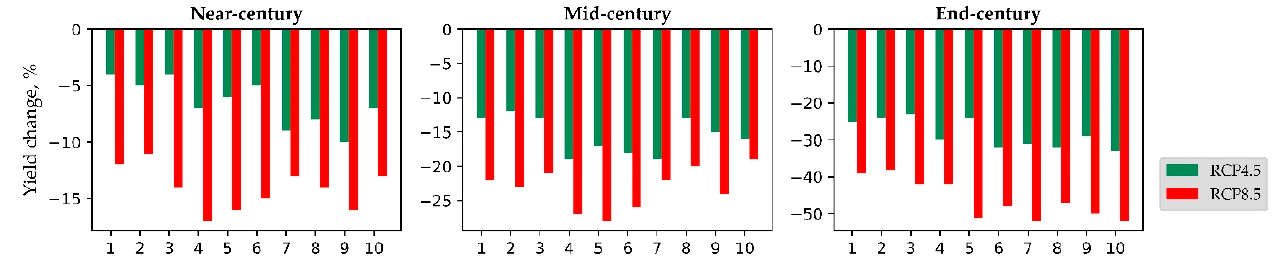
Figure 9. Percentage yield change in ten maize-producing counties in northeastern Kansas. The number depicted the ten counties of our study area in sequence. 1, Atchison. 2, Brown. 3, Nemaha. 4, Geary. 5, Jackson. 6, Jefferson. 7, Marshall. 8, Pottawatomie. 9, Riley. 10, Shawnee.